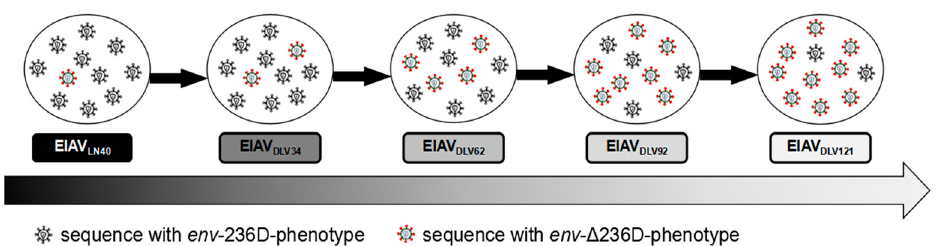
Figure 4. A schematic evolutionary model comparing the EIAV virulent strain to the vaccine strain during long-term passage in vitro. The virulent virus strains are presented with black circles, and the avirulent virus strains are presented with red circles. In this model, the env - ∆ 236D-phenotype sequences preexisted in EIAV LN40 as a minority population. With serial passages in vitro, sequences containing the env - ∆ 236D-phenotype gradually became the predominant EIAV quasispecies and generated high replicative fidelity under the new environmental selection conditions. Virulence was simultaneously attenuated as a result, as discussed in the text.